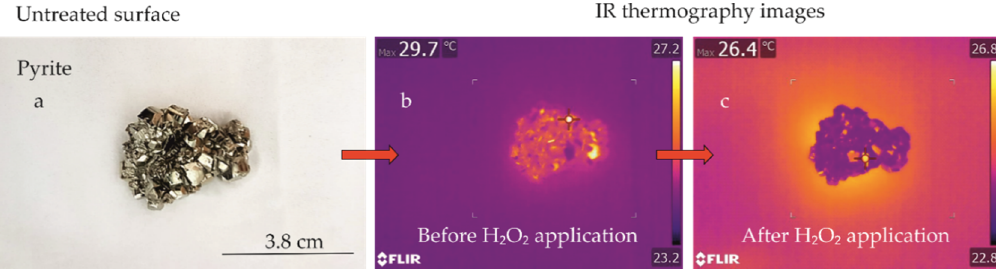
Figure 2. ( a ) Picture of untreated pyrite prior to treatment. ( b , c ) IR thermography images of pyrite before and after the application of the 30% H 2 O 2 solution to the pyrite surface. The maximum temperature measured and temperature distribution across the images are also shown.